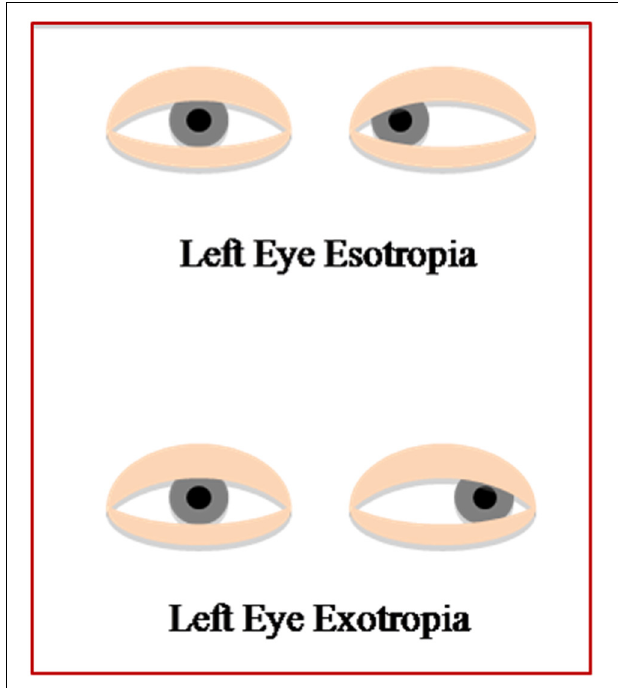
FIGURE 1 | Description of the eye direction, deviated toward the temple in patients with EXO and deviated toward the nose in patients with